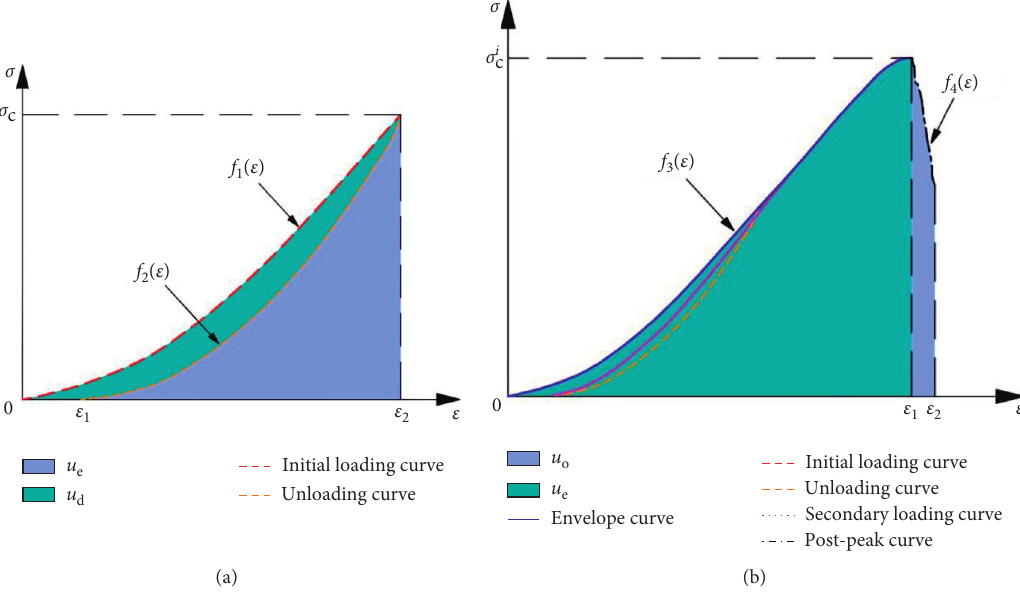
Figure 2: Calculation method of energy density. (a) Calculation of energy density at unloading point. (b) Calculation of energy density at peak